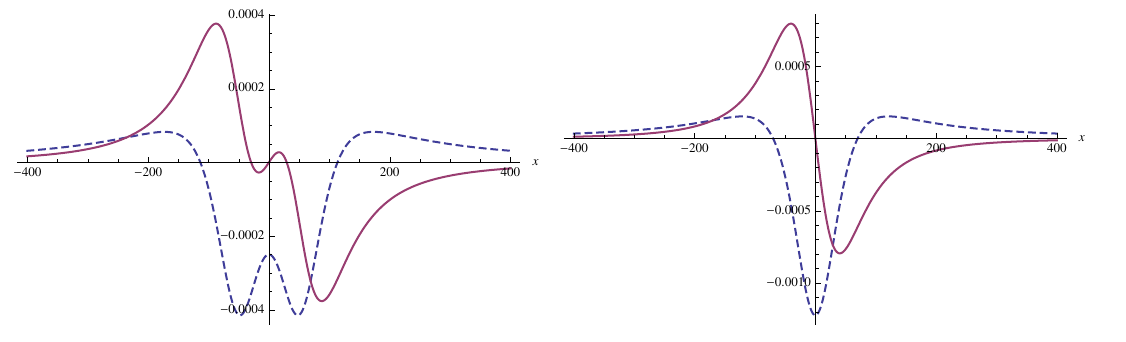
Figure 2 . Real and imaginary parts of (2.33) of a stationary case (2.34) at α = 100, and ν = (on the left) and ν = 0 (on the